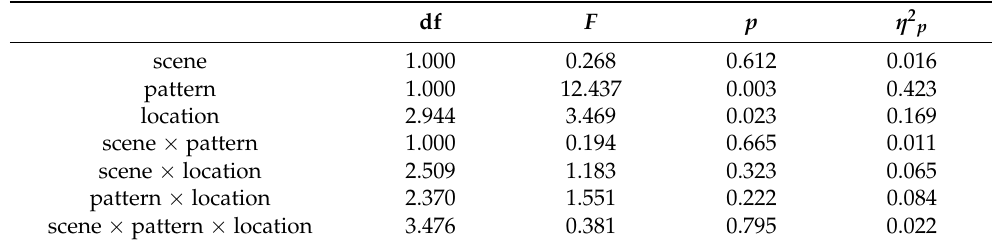
Table 3. The main effect of a three-way rmANOVA in the late component.